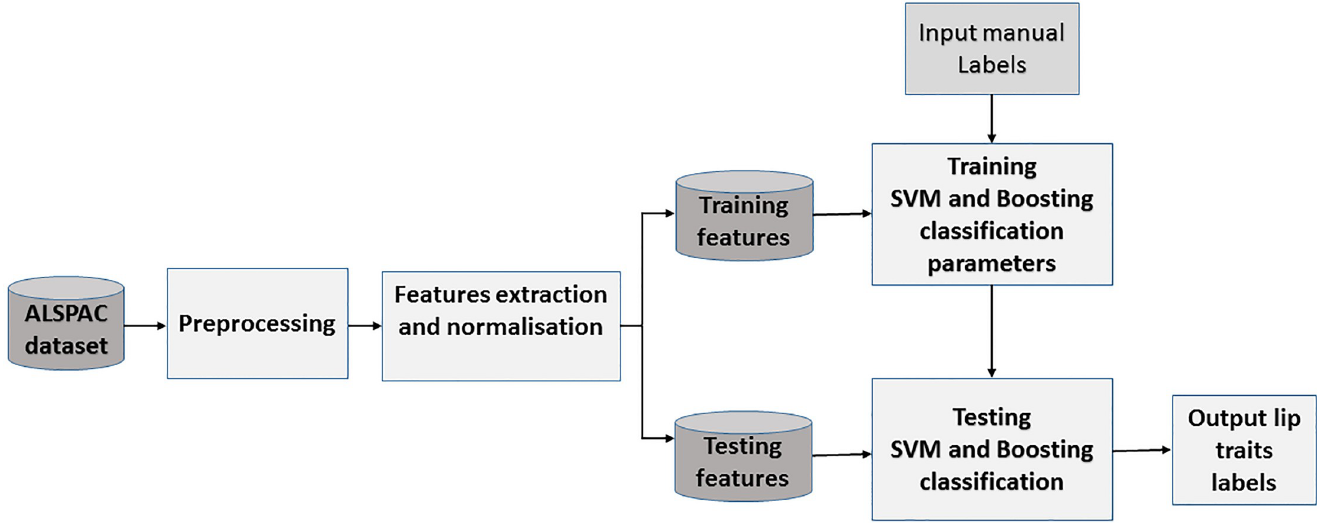
Fig 4. Classification block diagram. This diagram illustrates the proposed approach for automatic classification lip traits.